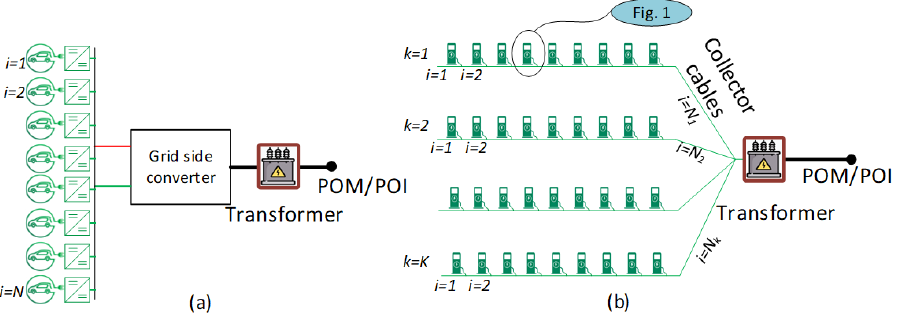
Figure 2. Schematic diagram of a large-scale EVGI plant: ( a ) multiple converters in source side connected to a single grid side converter, and ( b ) multiple EVGI systems connected together.